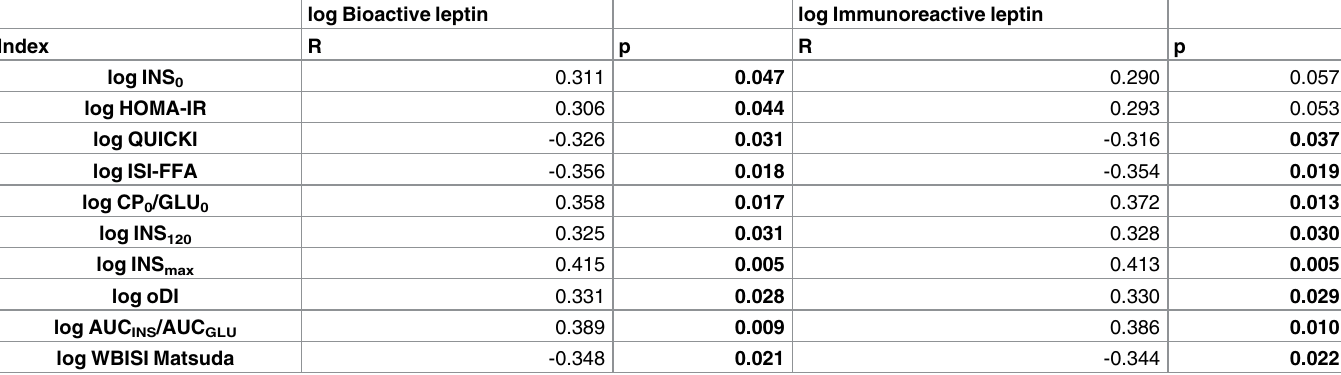
Table 2. Partial correlation between bioactive or immunoreactive leptin levels controlled for sex, age, BMI SDS, pubertal stage, and HbA1c and selected insulin secretion or resistance